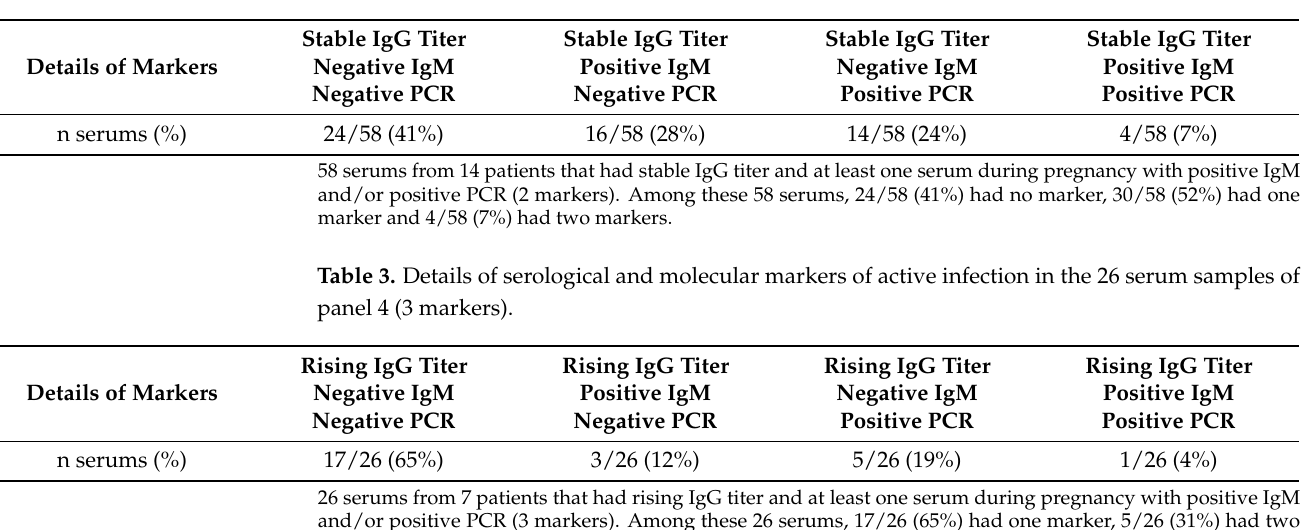
Table 2. Details of serological and molecular markers of active infection in the 58 serum samples of panel 3 (2 markers).